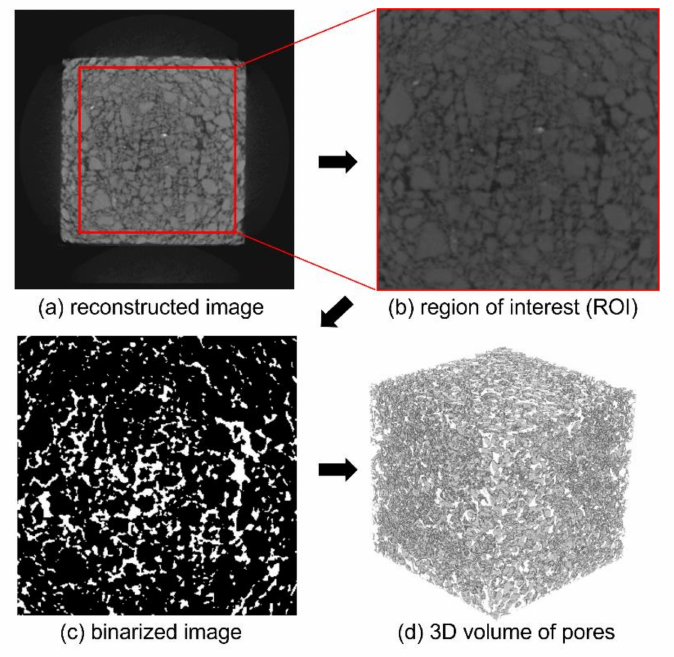
Figure 4. Micro-CT imaging process: ( a ) the original reconstructed image, ( b ) ROI image, ( c ) binary image, and ( d ) 3D volume image (Note: in ( c , d ), the white region represents the pores within the